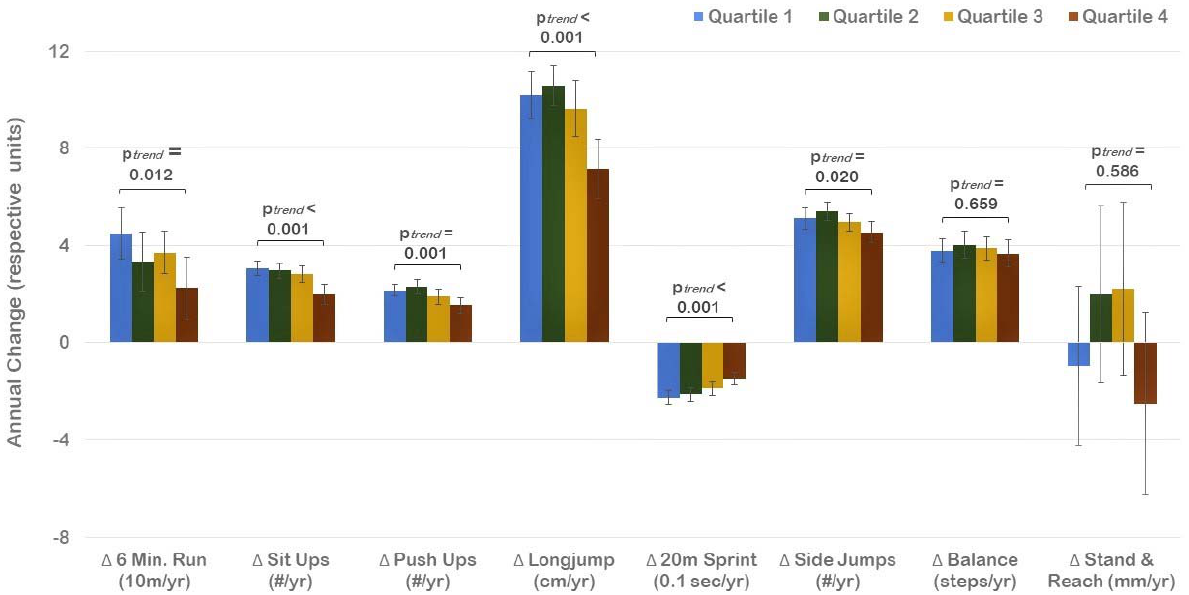
Figure 2. Change in physical fitness across quartiles of baseline BMI percentile (Quartile 1 indicates lowest BMI percentiles). Values are Mean with 95%